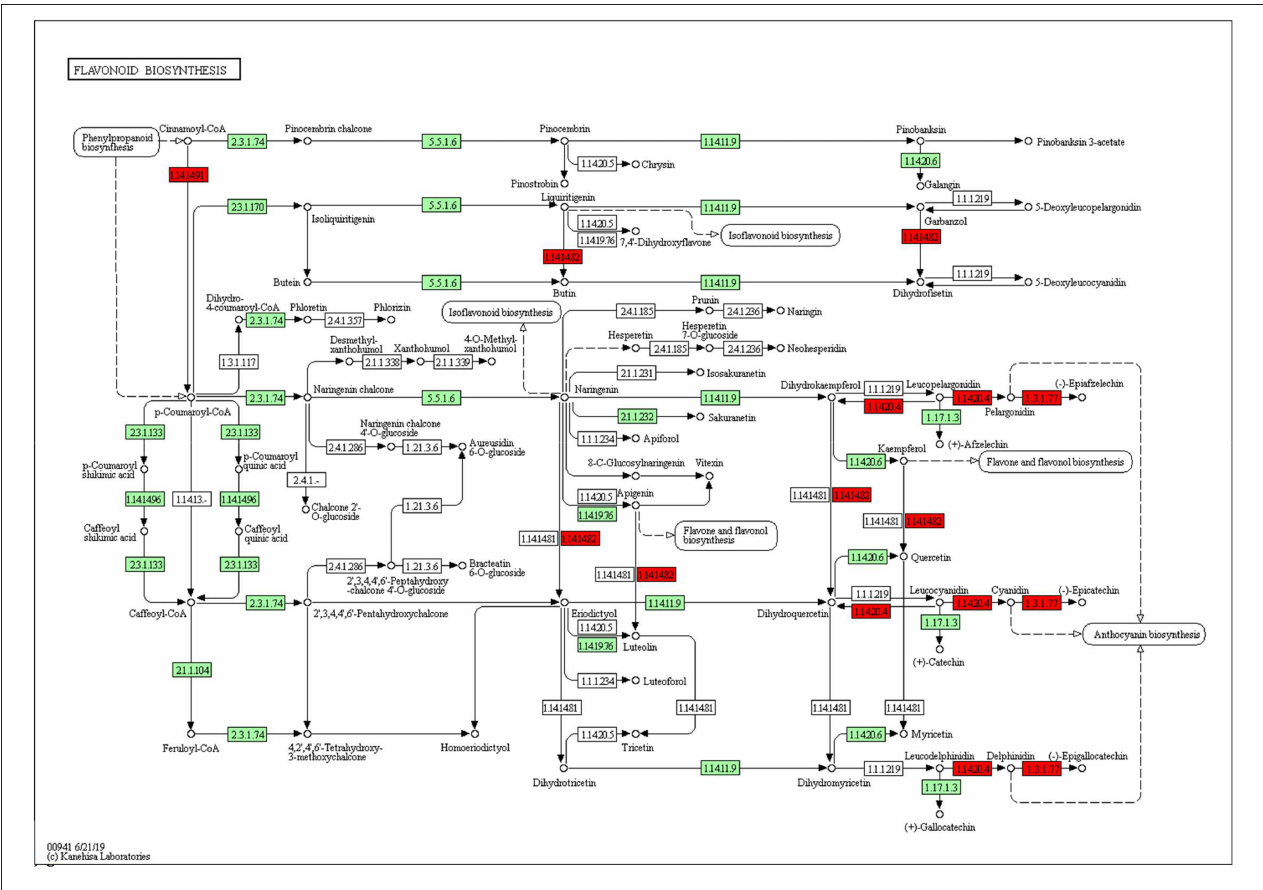
FIGURE 4 | Flavonoid biosynthesis pathway. (1.14.14.91) Cytochrome P450 CYP73A100. (1.14.14.82) Flavonoid 3’-monooxygenase. (1.14.20.4) Leucoanthocyanidin dioxygenase. (1.3.1.77) Anthocyanidin reductase. Red color represents significant and characterized enzymes based on Oryza sativa annotation. Green color represents significant and non-characterized enzymes. White color represents characterized enzymes based on Arabidopsis thaliana annotation.